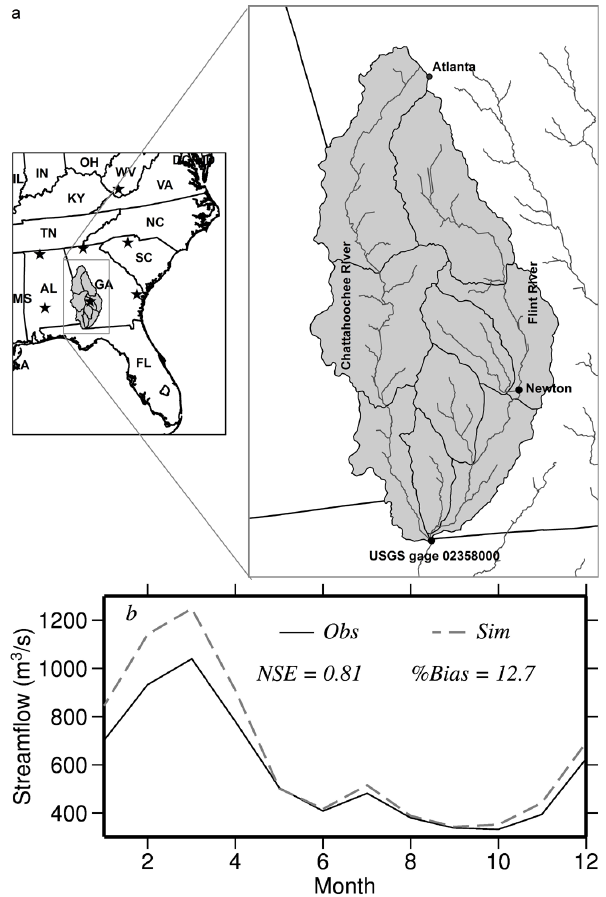
Fig. 1. Location of the Apalachicola River at Chattahoochee, FL, (a) and observed (Obs) and VIC model simulated (Sim) streamflow seasonality (b) for the VIC model evaluation period of 1981–2010 at USGS gauging station 02358000. Stars indicate location of 7 se- lected ECHAM4.5 grids. Figure 1b also shows the Nash–Sutcliff efficiency (NSE) and %bias over the entire evaluation